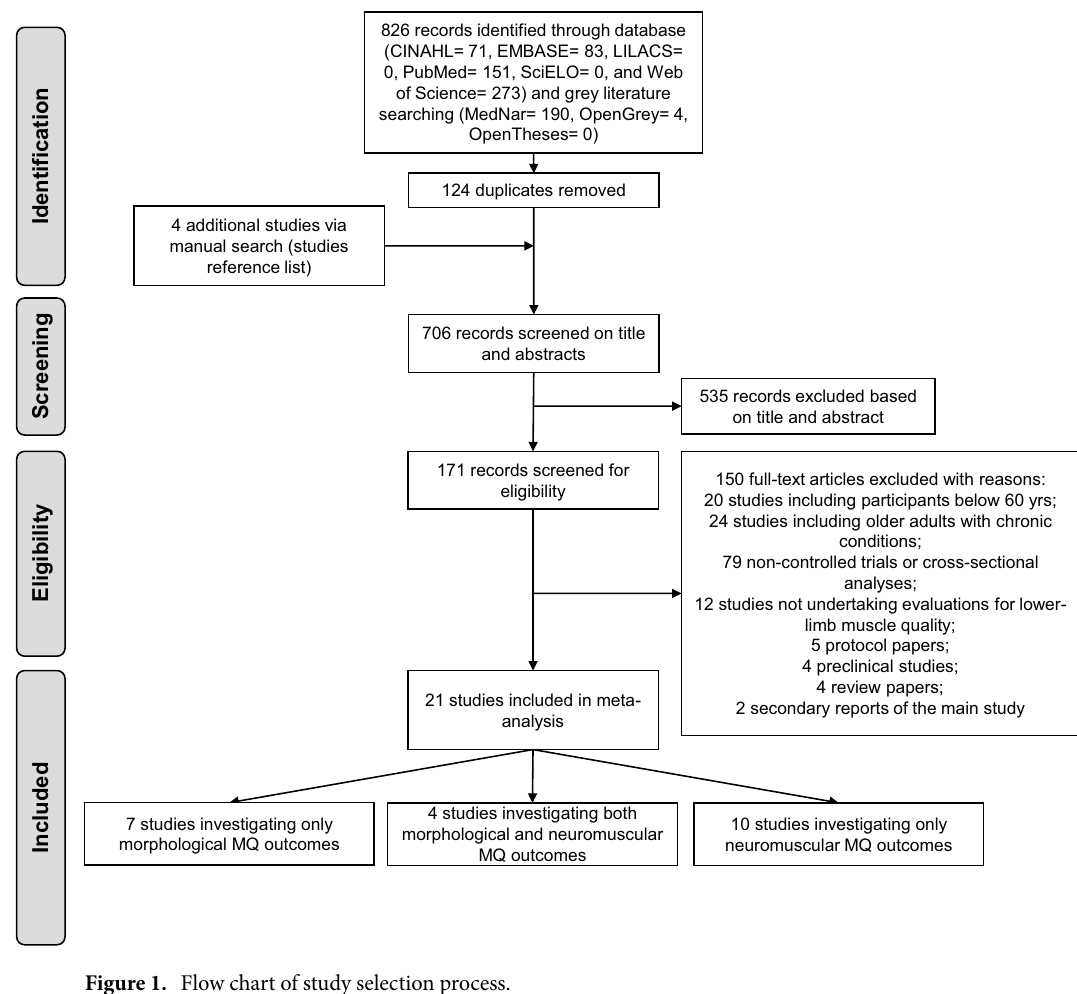
Figure 1. Flow chart of study selection